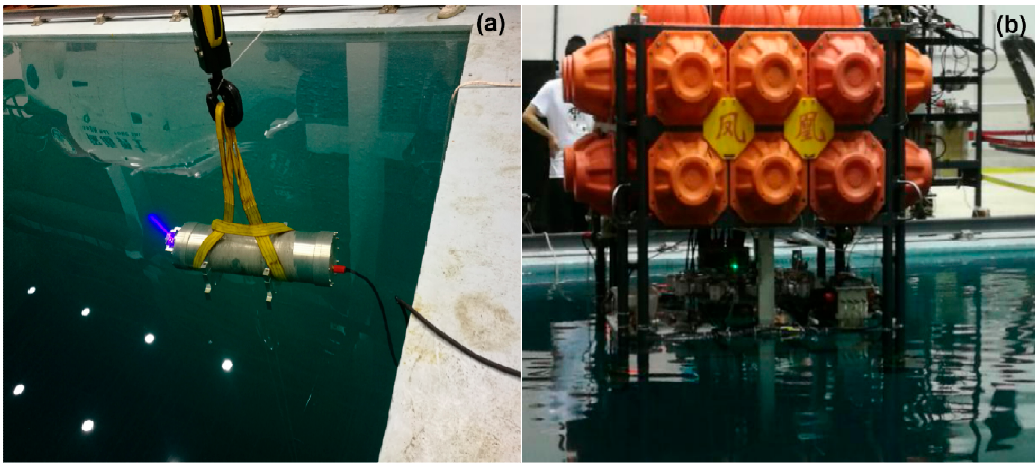
Figure 2. Sample pool design, where ( a ) is a simulated perspective view and ( b ) is a prototype.